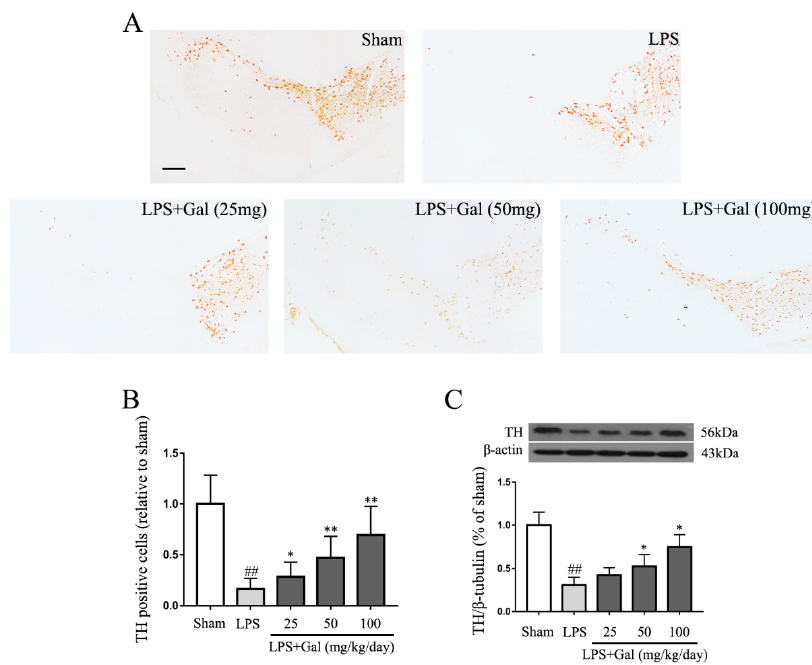
Figure 2. Galangin suppresses the loss of DA neurons in an LPS-induced PD rat model. The treatment is identical to what is described in Figure 1. ( A ) Staining of tyrosine hydroxylase (TH)-positive neurons in the SN with immunohistochemistry analysis, magnification shown is 4×, the scale bar represents 100 μ m ( n = 4 per group); ( B ) The survival ratio of the dopaminergic neurons in the SNpc (TH positive cells) ( n = 4 per group); ( C ) The expression of TH was analyzed by western blot ( n = 4 per group). Data are means ± SD. ## p < 0.01 compared to the sham group, * p < 0.05 and ** p < 0.01 compared to the LPS group.